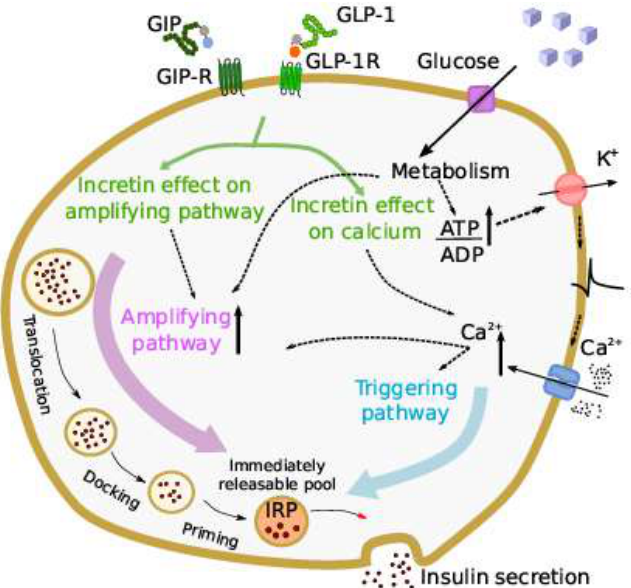
Figure 3. Scheme of the incretin effect in the model by Grespan et al. [28]. Incretins are assumed to act on both the triggering and amplifying pathways that regulate insulin secretion in beta-cells, increasing the cytosolic calcium (Ca 2+ ) and amplifying insulin secretion through intracellular cAMP-dependent pathways (figure taken by Grespan et al. [28]).